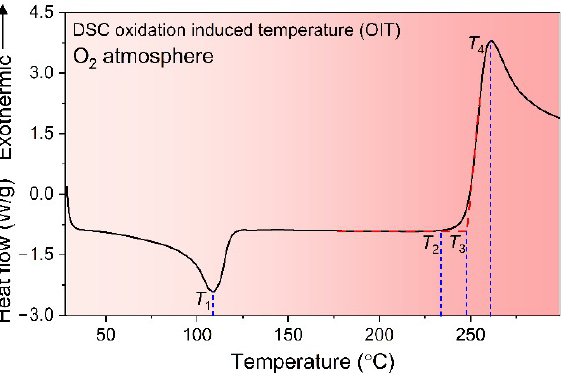
Figure 5. Schematic diagram of OIT curve of XLPE material based on the DSC